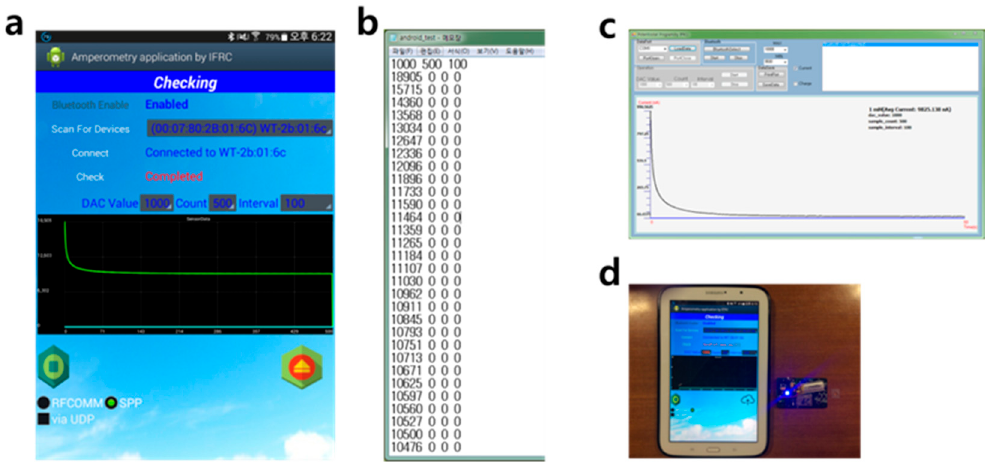
Figure 6. ( a ) Results for 1 mM Ru III shown on smart tablet; ( b ) Result data in text file format; ( c ) Graph of the current in PC program; ( d ) Smart table used in experiment.